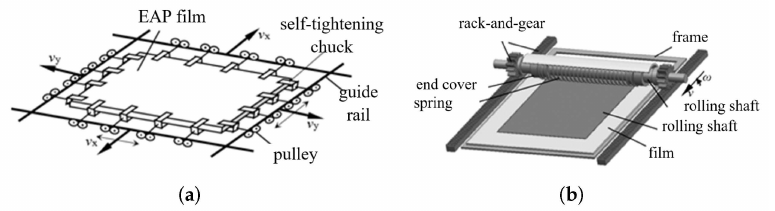
Figure 4. Schematic diagram of winding unit manufacturing equipment, where ( a ) is plane stretching platform and ( b ) is coiler.